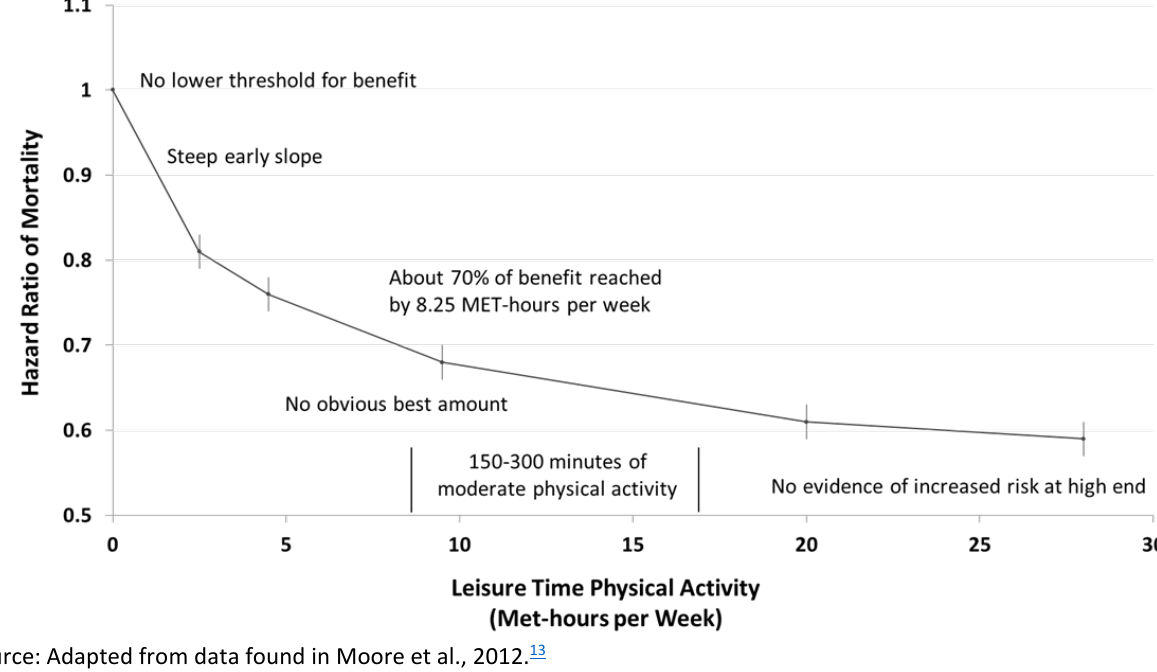
Figure F6-2. Relationships of Moderate-to-Vigorous Physical Activity to All-Cause Mortality, with Highlighted Characteristics Common to Studies of This